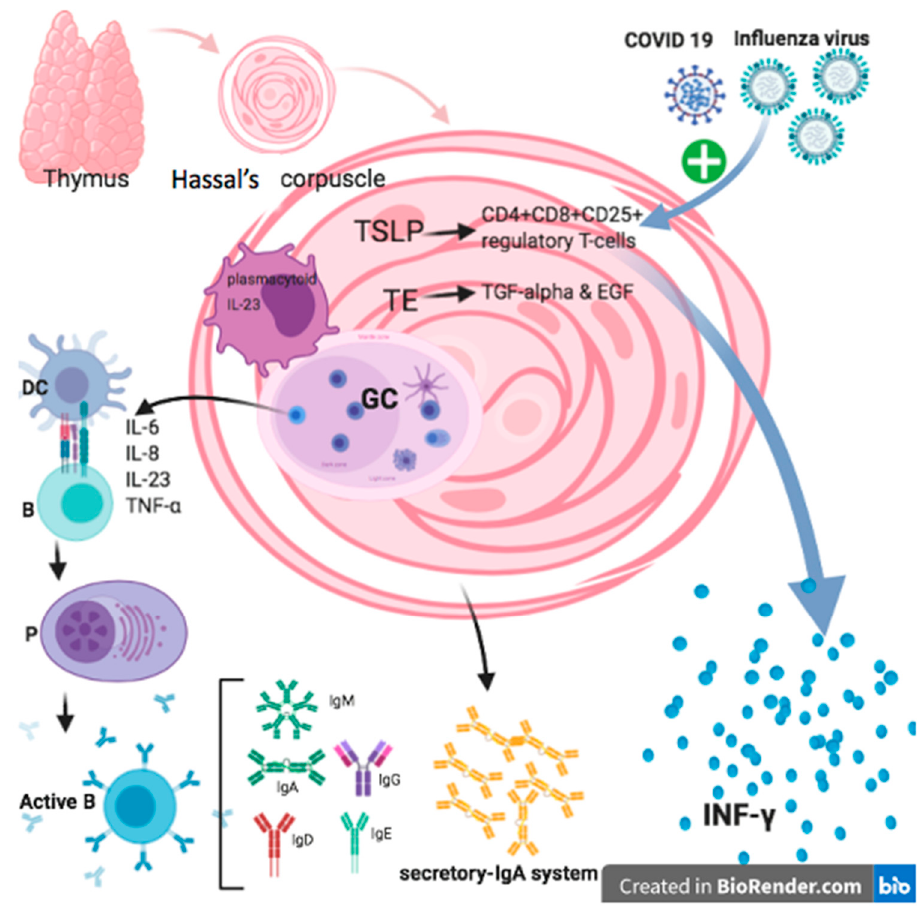
Figure 3. Functions of thymic Hassall’s corpuscles in normal state and after infection with influenza virus. Thymic stromal lymphopoietin (TSLP), a cytokine that is the primary hormone produced by the epithelial cells of Hassall’s corpuscles, was found in the thymus and was responsible for the activation of thymic dendritic cells. Hassall’s corpuscles secrete TSLP-inducing dendritic cells to induce and generate CD4+ CD8+ CD25+ regulatory T cells within the thymus. Thymic plasmacytoid dendritic cells express IL-23 receptors. Transforming growth factor alpha (TGF- α ) was identified in medul- lary human thymic epithelial (TE) cells and thymic Hassall’s corpuscles while epidermal growth factor receptor (EGF-R) was concentrated to TE cells through the thymus tissue. Hence, TGF- α and EGF are crucial regulatory precursors for the synthesis of TE cell-derived cytokines in the thymus. The human thymus shows the existence of antibodies IgG, IgA, IgM, IgD, and IgE, which are secretory constituents in Hassall’s corpuscles. There is a strong connection between the amounts of IgA and secretory components in the cells of Hassall’s corpuscles, and the thymus may have to be considered as an active portion of the secretory-IgA system of Hassall’s corpuscles. The influenza virus activates thymic CD4+ CD8+ thy- mocytes, leading to the secretion of a large amount of interferon IFN γ . IL-1 α / β enhances IgM and recruitment of CD4+ T cells at the site of infection but does not contribute to killing the virus-infected cell [37]. Additionally, CD4+ but not CD8+ Treg cells were suppressed by IL-6, allowing pathogen clearance and host survival in virus- induced infection [38]. In H1N1 influenza, IL-6 levels elevated in severe cases of virally infected patients [39] and activated CD4+ CD8+ thymocytes and a large amount of IFN γ [40]. While IL-32 is a part of a negative feedback loop, inhibiting sIL-6R and upregulating IL-6 is essential for the survival of an influenza A virus infection [35,41]. Few immunode- ficiency viral diseases have been linked with the thymus in childhood, including thymic lymphoid hyperplasia (thymitis), loss of Hassall’s corpuscles, and dysinvolution [14]. Hassall’s corpuscles were found to be altered and damaged in a 4-year-old boy infected with herpes simplex virus pneumonia and ependymoma [15]. Modulation in the size of the thymus has been associated with hyperactivation of dystrophic calcification of Hassall